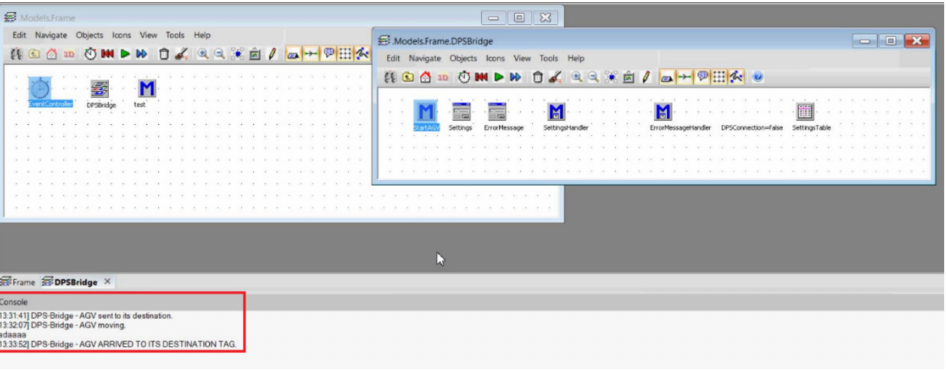
Figure 12. Information Window on AGV Activities in the Simulation Model (processed in Tecnomatix Plant Simulation).